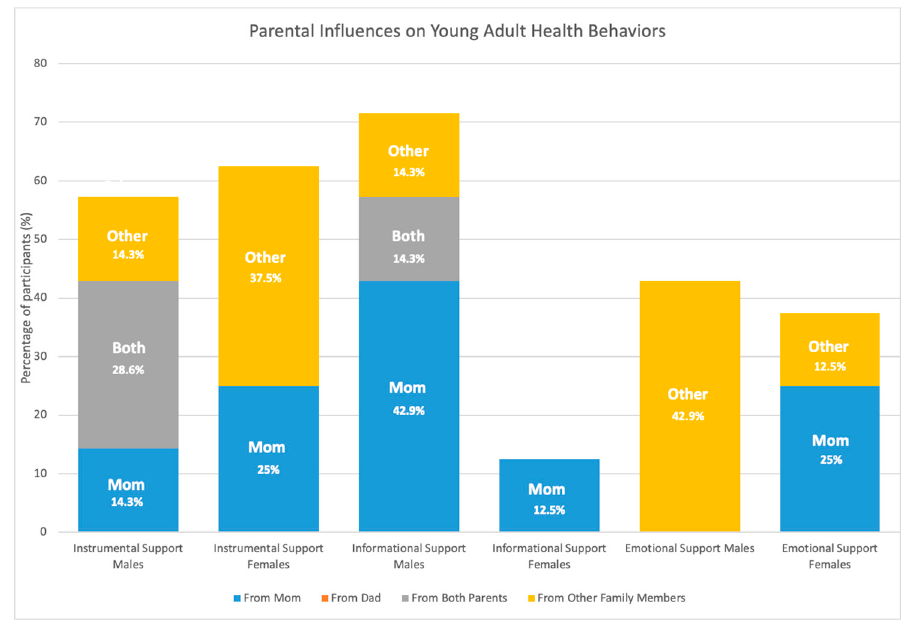
Figure 3. Young adult perceived family social support on health behaviors.